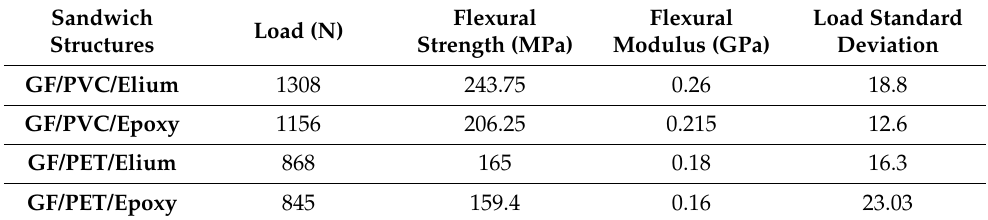
Figure 4. Load vs. displacement of GFRP sandwich composites. Table 4. Flexural test results of sandwich composites.